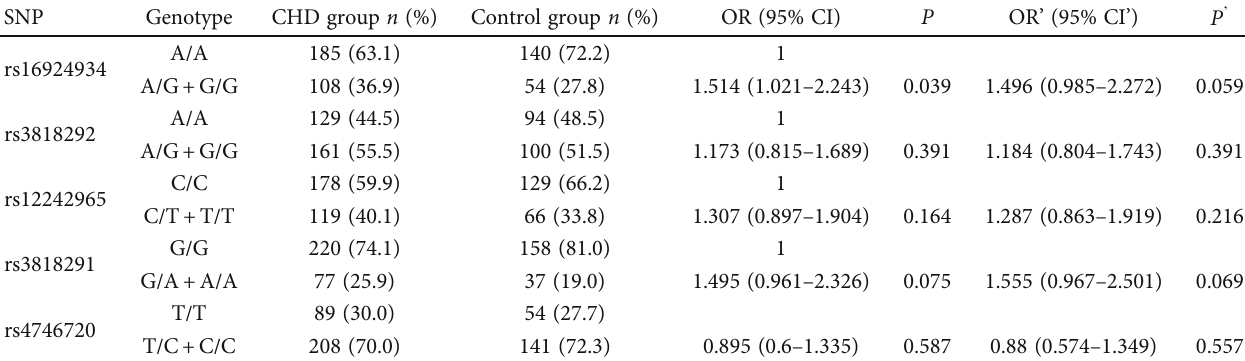
Table 4: Dominant inheritance model of the distribution between CHD and control